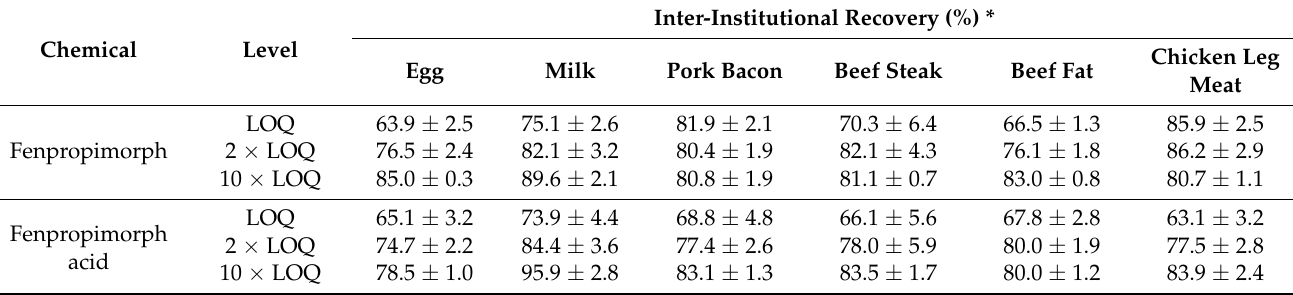
Inter-Institutional Recovery (%) *